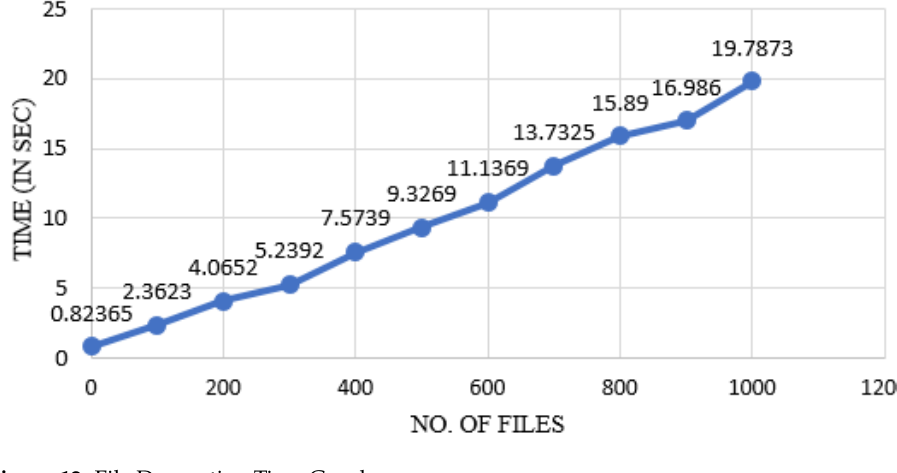
Figure 12. File Decryption Time Graph.